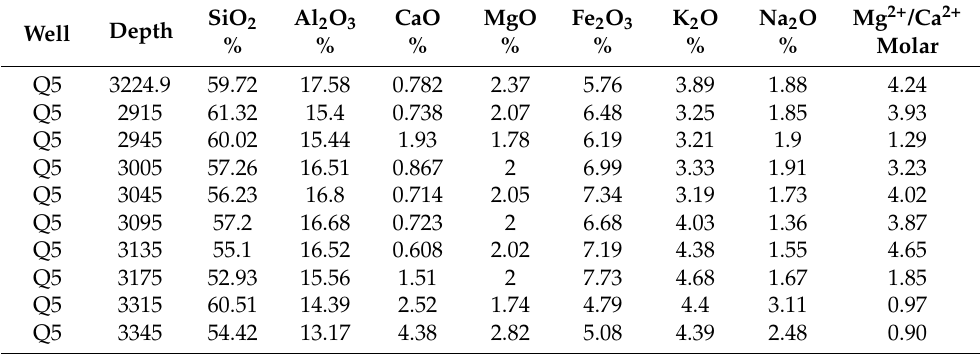
Table 2. Macroelemental compositions of mudstone in E 2